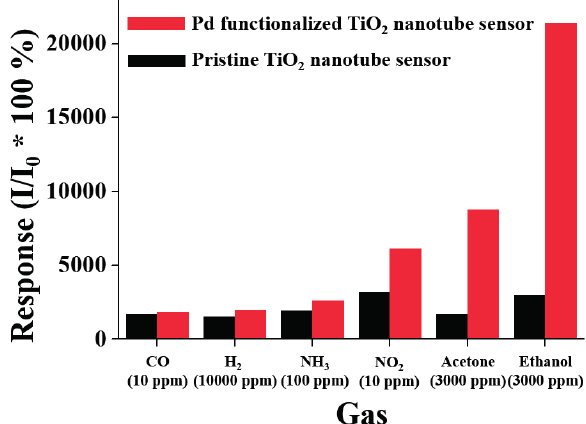
nanotubes to different 2